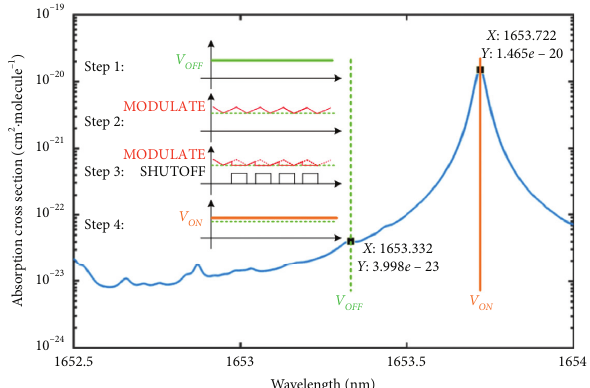
Figure 9: Schematic diagram of operation process of differential